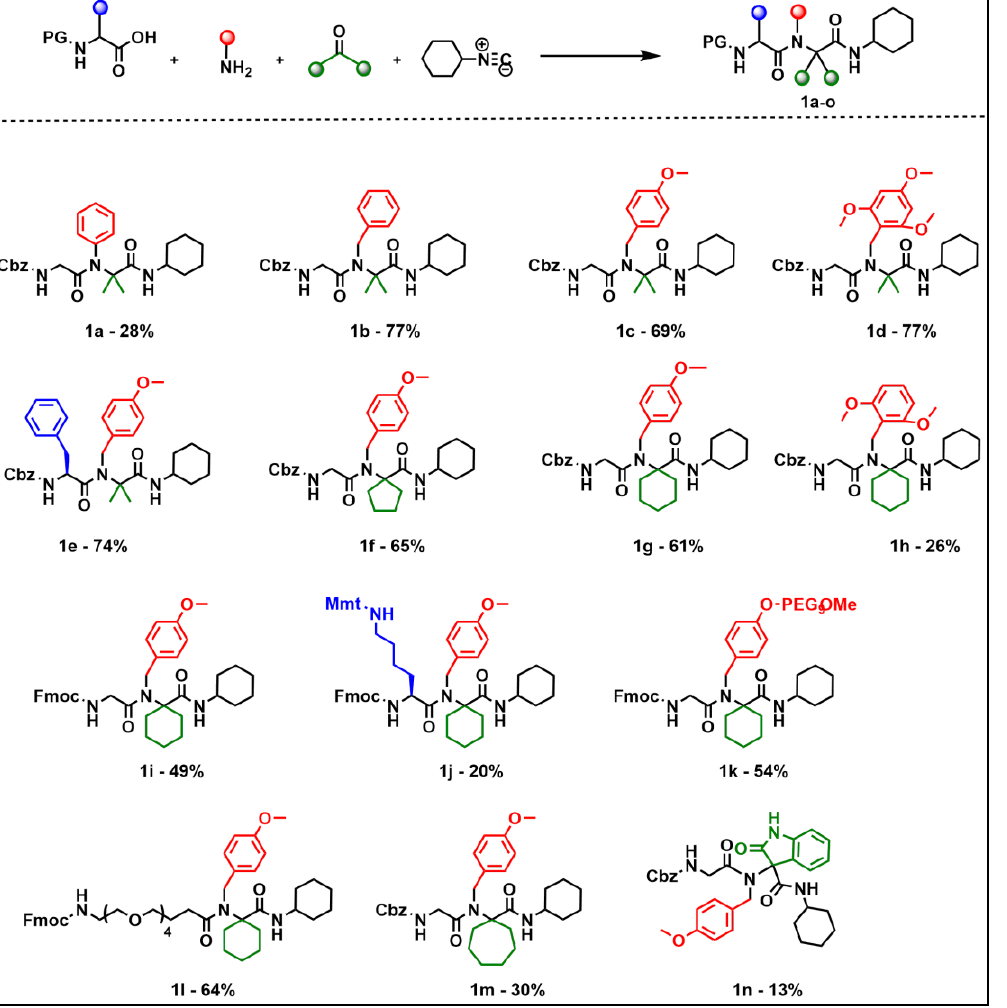
Figure 2. The U-4CR to yield N -alkylated α,α-dialkylglycine (1a–n).